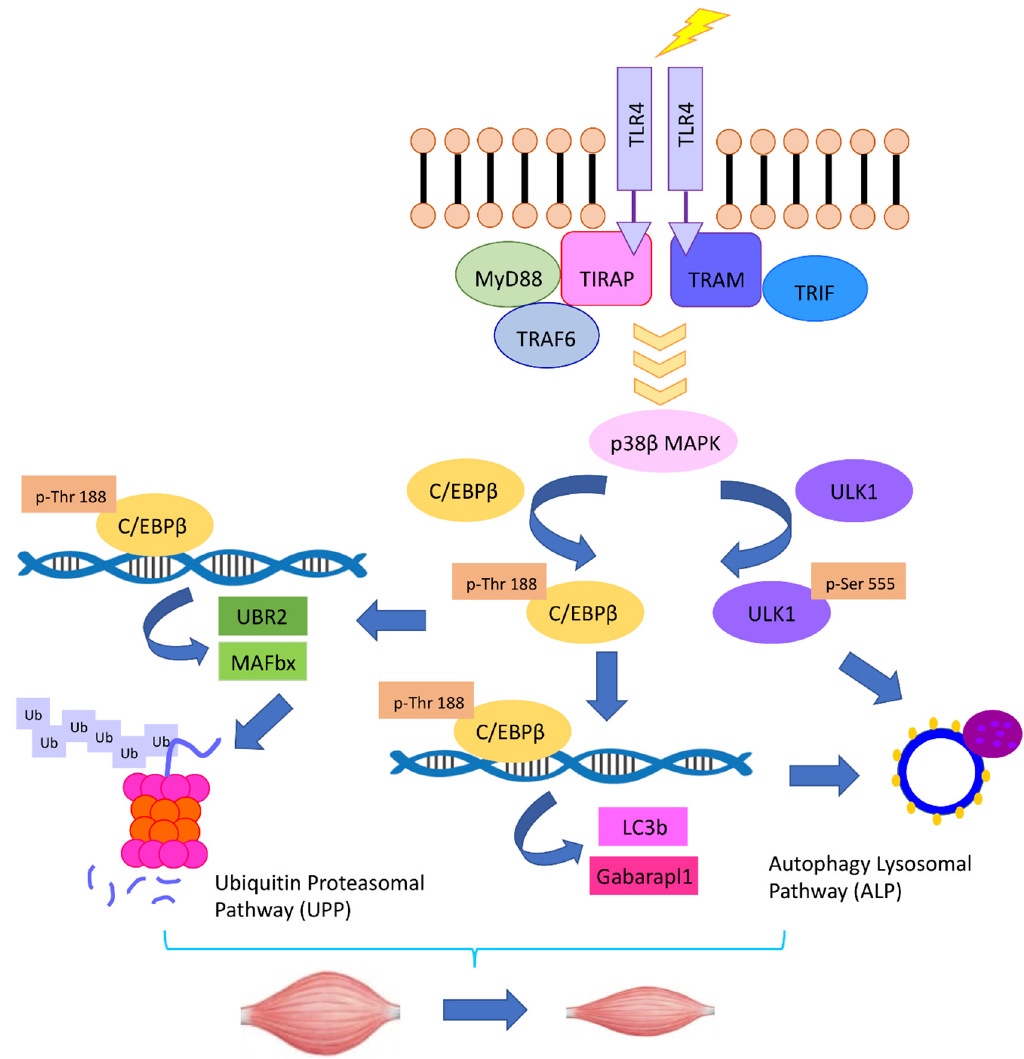
Figure 1. The TLR4–p38 β MAPK–C/EBP β signaling pathway mediates the coordinate activation of UPP and ALP in cancer-induced muscle catabolism.